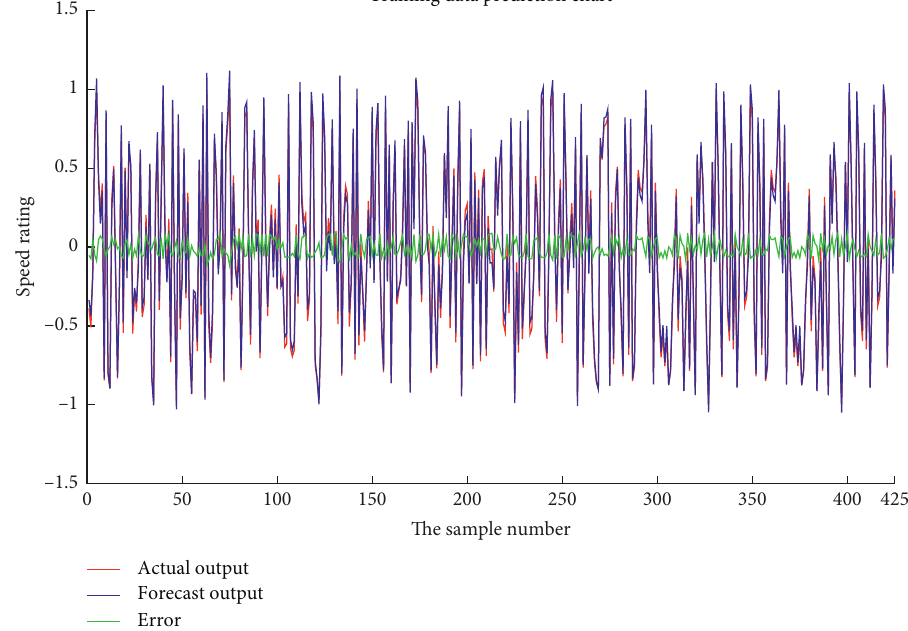
Figure 4: Traditional T-S fuzzy neural-network training data prediction